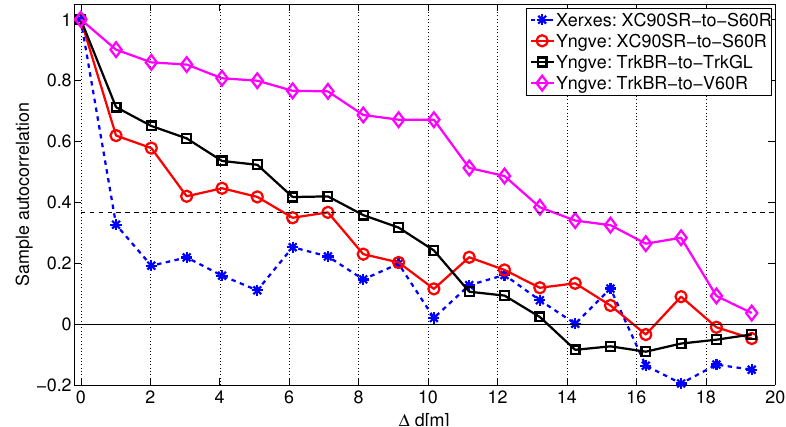
Figure 11. Auto-correlation as a function of traveled distance for four out of the 25 communication links.